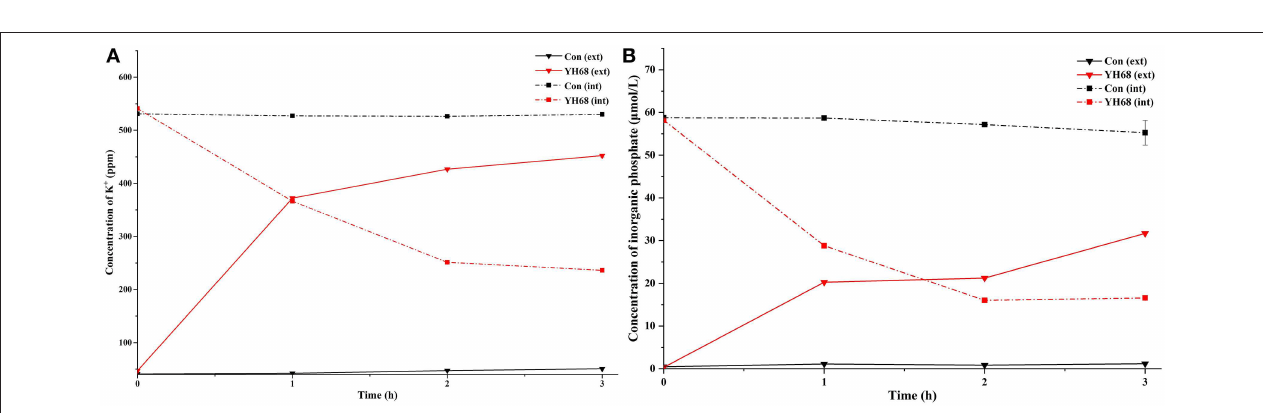
can be stained by PI with the excitation of red